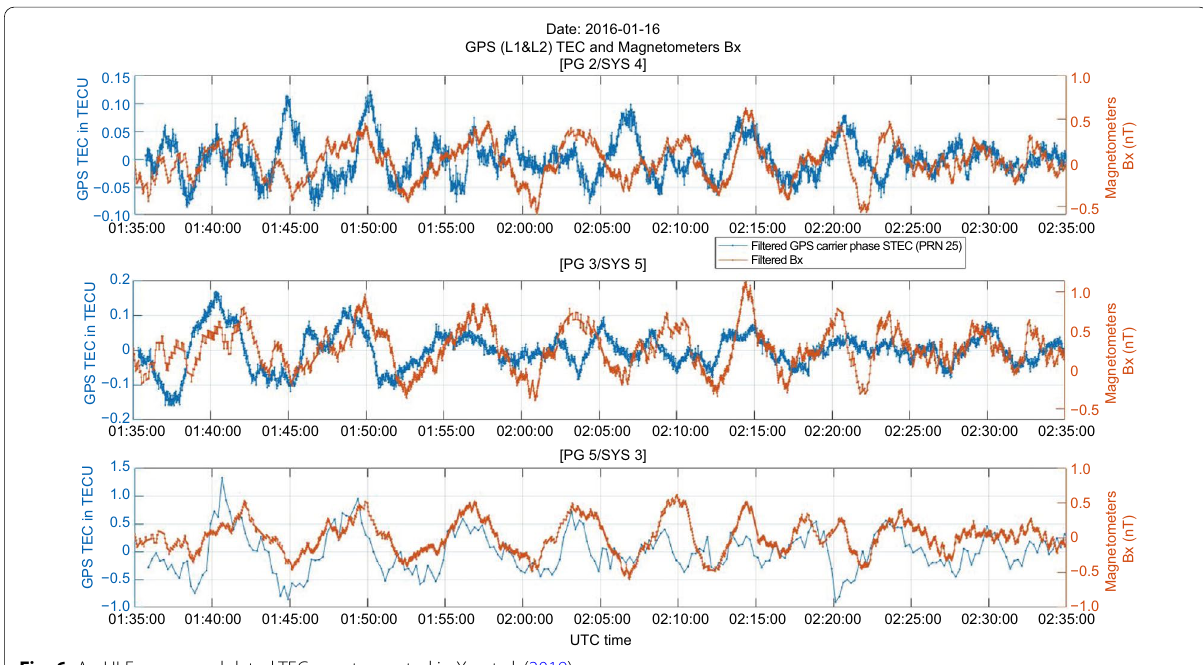
Fig. 6 An ULF-wave modulated TEC event reported in Xu et al.